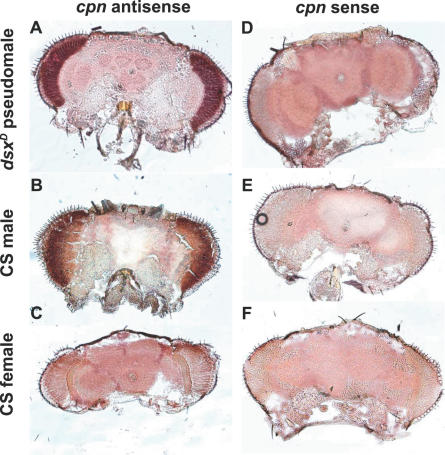

cpn Shows Higher Expression in Males and dsxD Pseudomales than Females and Is Localized to the Retinal RegionIn all panels, 0–24-h adult head frozen-sections are shown.(A–C) In situ hybridization using cpn anti-sense probe.(D–F) In situ hybridization using cpn sense control probe. The genotype of the tissue is shown at the left of the panels.doi:0.1371/journal.pgen.0030216.g005